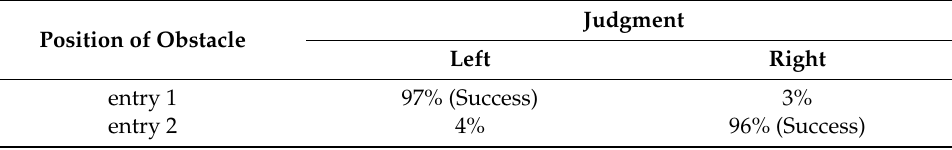
Table 6. Accuracy of identifying and judging the position of obstacles.